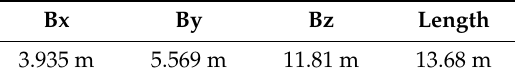
Table 4. Dimensions of the connecting rod.